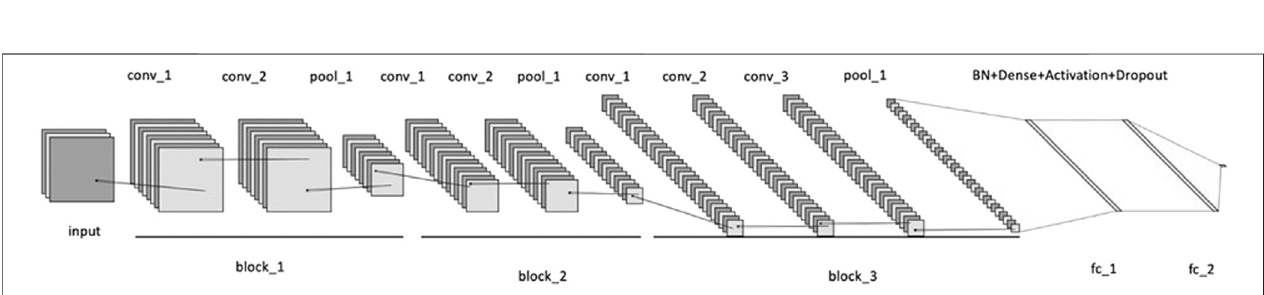
FIGURE 2 | Modi fi ed VGG16 architecture used in this